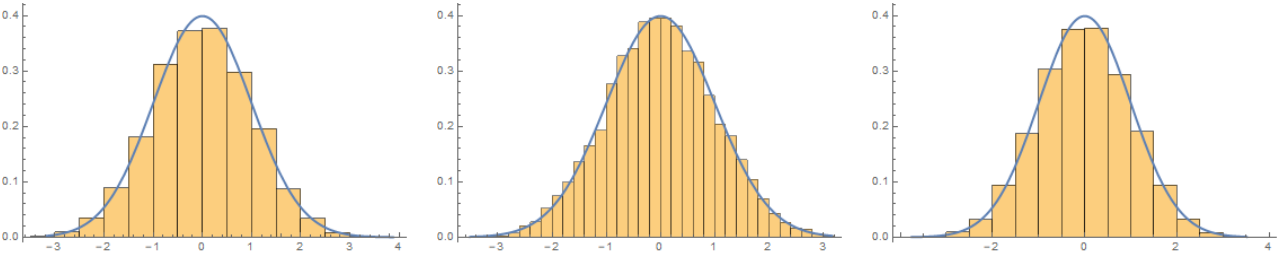
Figure 6. Plots of the histogrmas of the obtained results against their corresponding in a normal distribution for κ 5 7 , κ 6 8 and κ 88